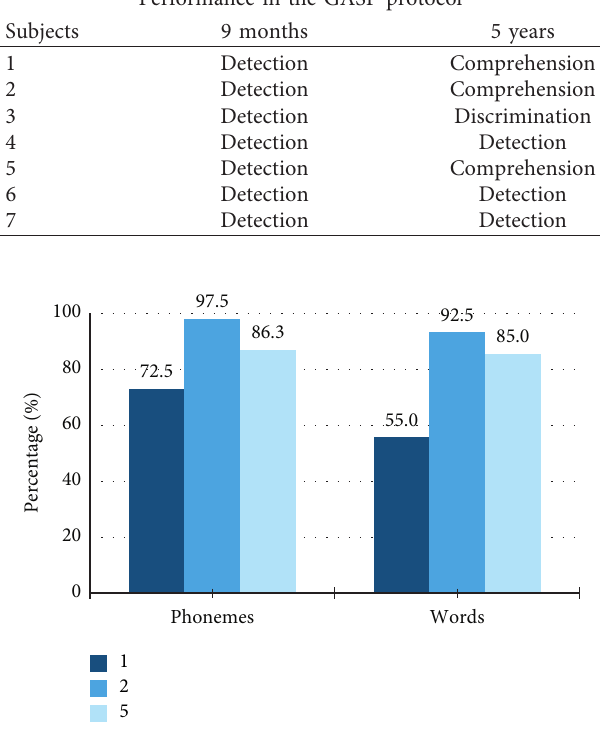
Figure 4: Percentage of phonemes and words correctly repeated on the words repetition test.